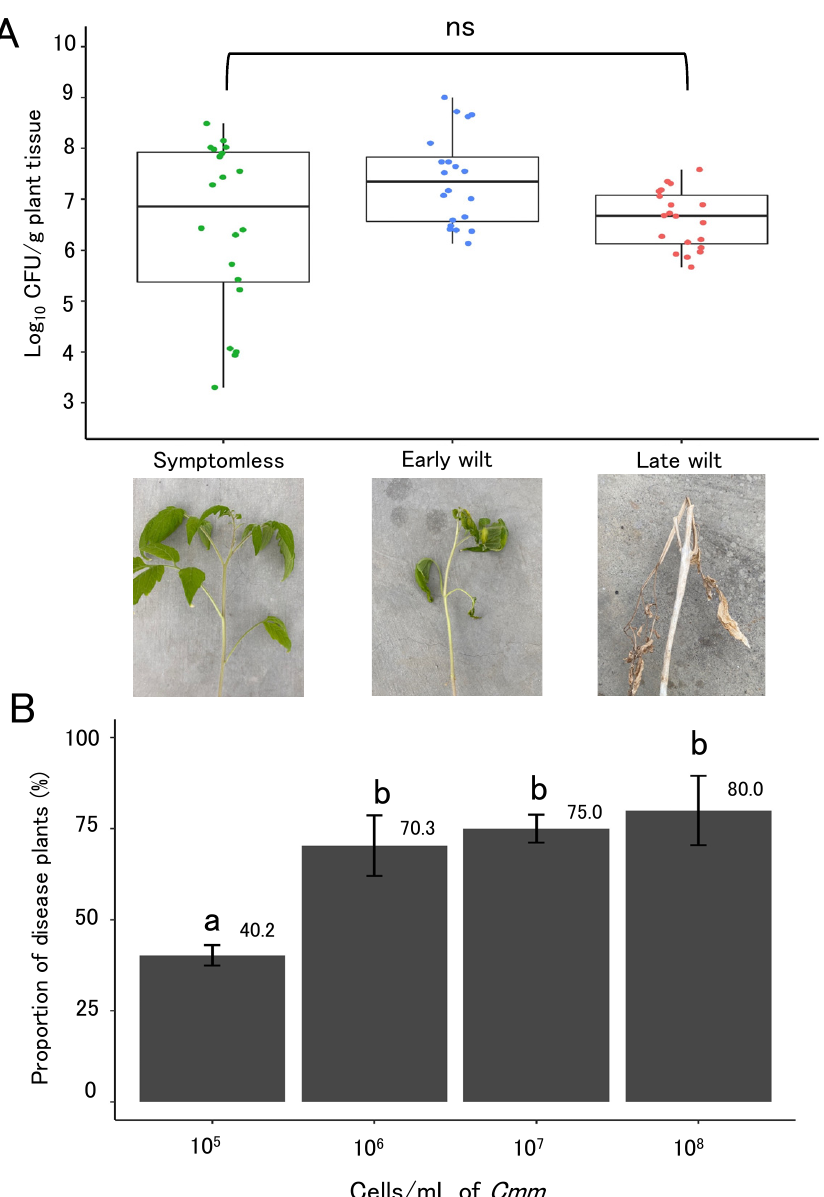
Figure 2. Relationship between populations of Cmm and probability of tomato bacterial canker (TBC) infection. ( A ) Populations of Cmm in tomato bacterial canker-infected plants, grouped according to symptoms (symptomless, early wilt, and late wilt). The center bar of the boxplot is the median, the lower and upper horizontal bars are the 25th and 75th percentile, and whiskers show the 95% range. The values of log 10 CFU/g plant tissues with three different symptoms were not significantly different (ns, p > 0.05, ANOVA). ( B ) Proportion of diseased plants inoculated with different concentrations of Cmm . Error bars show standard error of mean (SEM). Different letters indicate a significant difference from the other bars in different concentrations of Cmm ( p ≤ 0.05, Tukey’s HSD test).